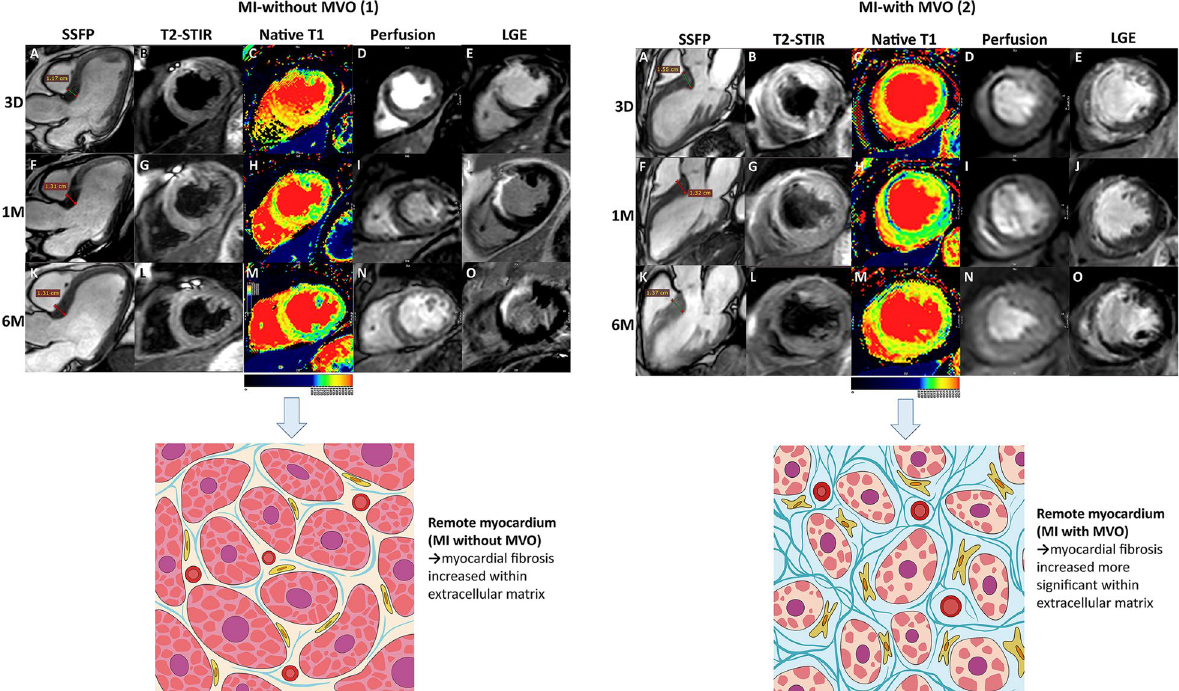
Fig. 2 Native T1 values of remote myocardium in patients with and without MVO changed from 1 week to 6 months after MI dynamically. The native T1 value of remote myocardium in the first week was higher than those of 1 month. Inflammation of remote myocardium increased in the acute phase while diminished gradually during follow‑up, and fibrosis of remote myocardium increased gradually. Native T1 values were determined by myocardial fibrosis in the chronic stage. The first patient had mural thrombosis in the apical during the first week. Compensatory thickening of the basal left ventricular septum was greater in patients with MVO than those without